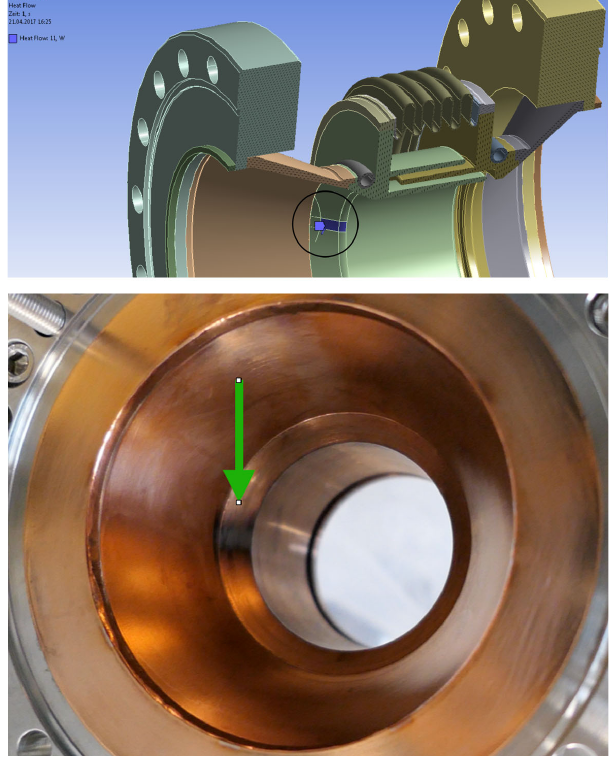
FIG. 5. Synchrotron light impact zone as assumed in the thermal simulation (above, encircled) and discoloration found very close to the estimated place after operating and dismantling CSB1 in the estimated area (below, green